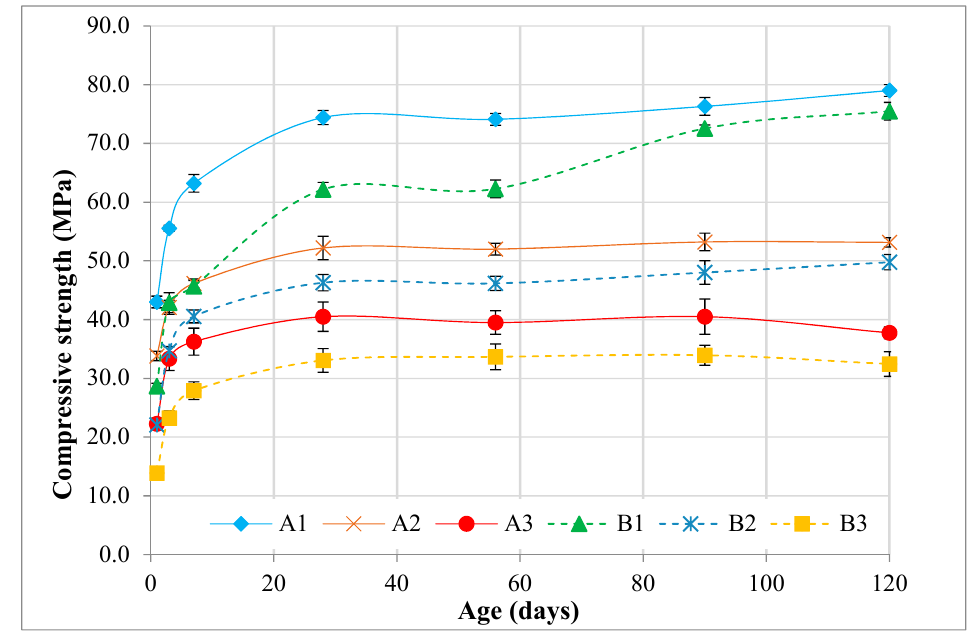
Figure 8. Compressive strength development of concrete mixes (MPa).